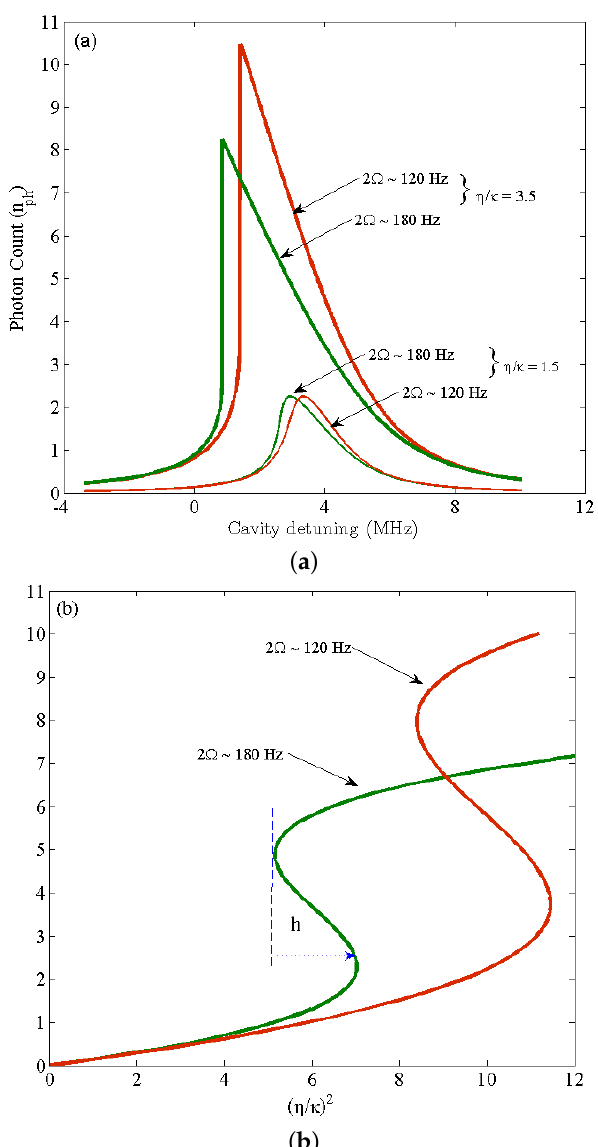
Figure 5. Steady-state interactivity photon number as a function of ( a ) pump cavity detuning for a set of synthetic field and η / κ ; ( b ) pump rate for the same set of synthetic fields and cavity detuning ∆ = 2 π × 2.5 MHz. Figure taken from [33]. (Reprinted figures with permission from Padhi, B.; Ghosh, S. Phys. Rev. Lett. 2013, 111, 043603. Copyright (2013) by the American Physical Society. Source: